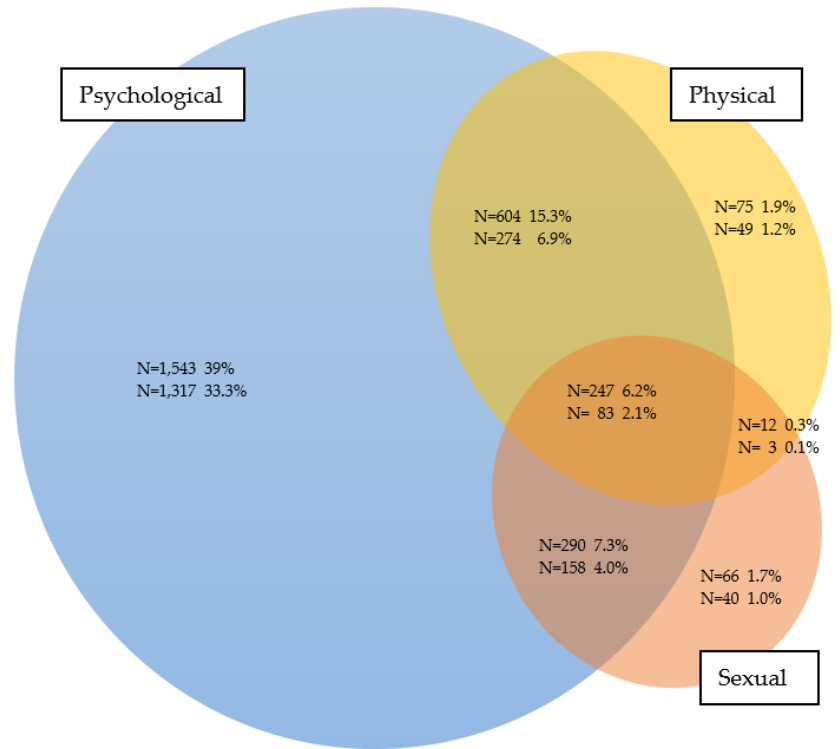
Figure 1. Proportions and overlap of the three types of TB, with and without leaving an impact (low-threshold measure, i.e., at least one reported experience).